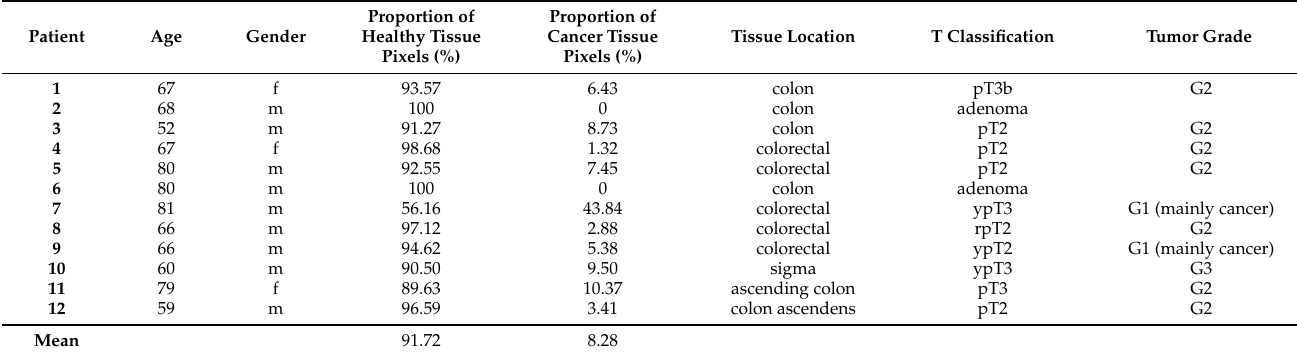
Table 1. Summary statistics of the colon dataset. There is one hypercube per patient. Each pixel corresponds to 100 hypercube voxels. These voxels give the relative reflectance at 100 wavelengths for a given pixel. Patients 2 and 6 did not have cancer.